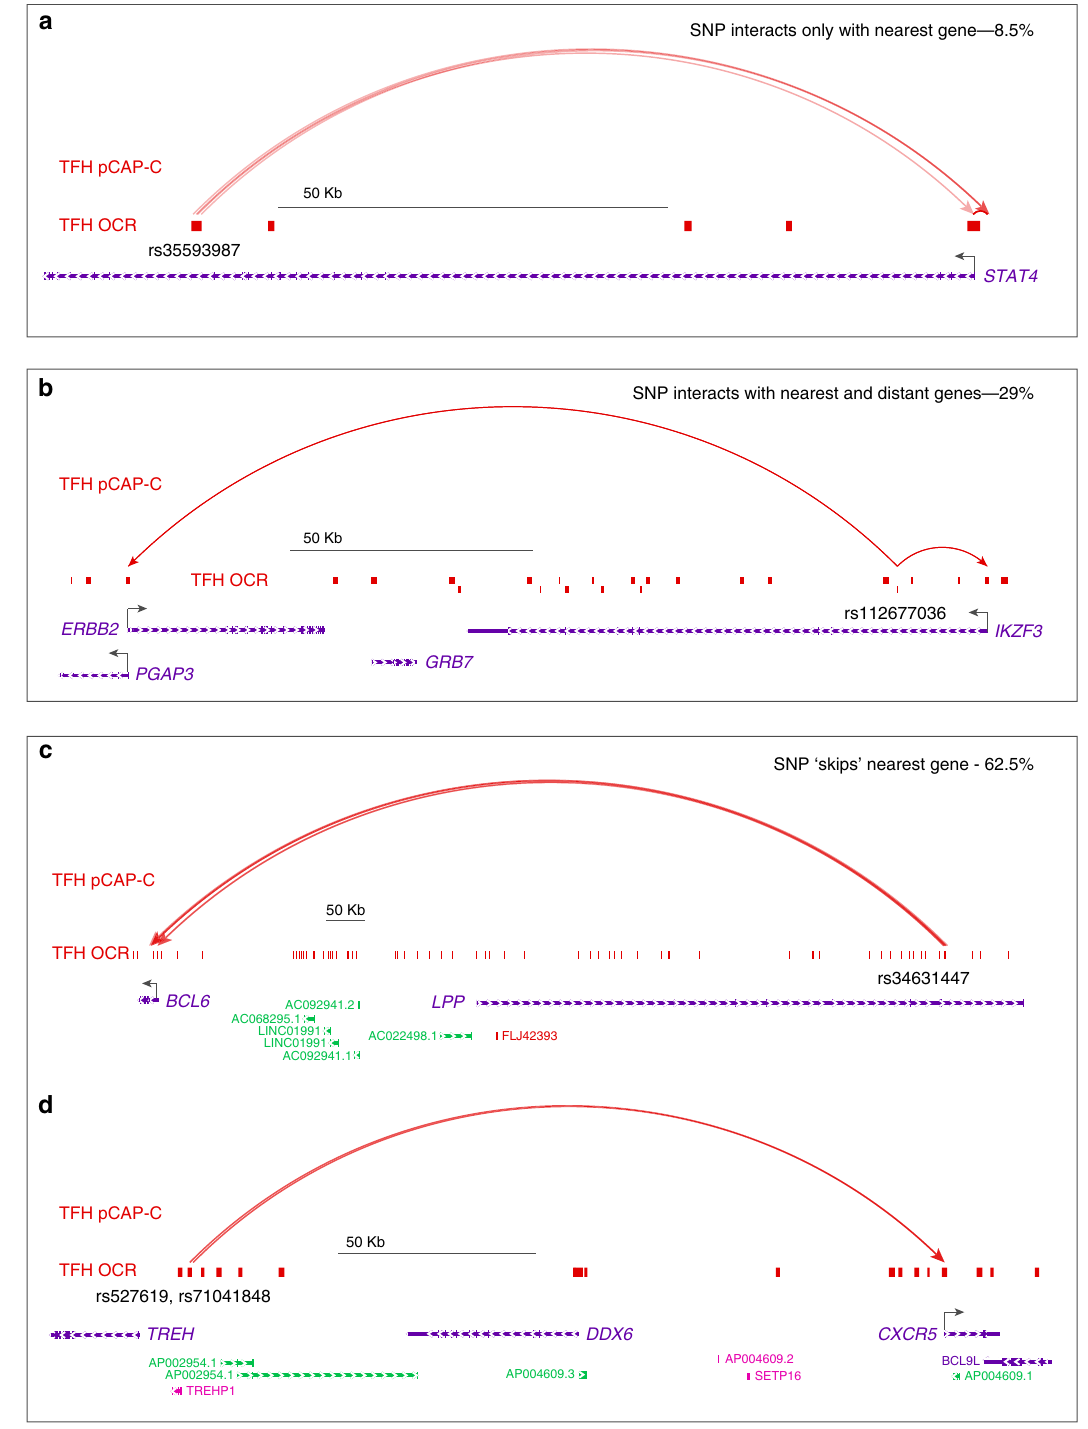
Fig. 6 SLE variant-to-gene mapping through integration of GWAS and promoter-open chromatin connectomes in follicular helper T cells. Four categories of accessible SLE SNP-promoter interactions were detected. a Accessible SLE SNP uniquely interacts with the nearest promoter (8.5%). An example is rs35593987 ( r 2 = 0.68), which physically interacts only with the nearest gene STAT4 . b Accessible SLE SNP interacts with the nearest promoter and at least one distant promoter (29%). An example is rs112677036 ( r 2 = 0.93), which physically interacts with IKZF3 and the distant ERBB2 and PGAP3 genes. c Accessible SLE SNP ‘ skips ’ the nearest promoter to interact exclusively with one or more distant promoters (62.5%). Examples are c rs34631447 ( r 2 = 1.0), which skips LPP to physically interact with BCL6 , and d rs527619 ( r 2 = 0.51) and rs71041848 ( r 2 = 0.44), which interact with the distant CXCR5 gene instead of the nearest gene, TREH. All interactions are based upon a CHiCAGO score lower threshold of